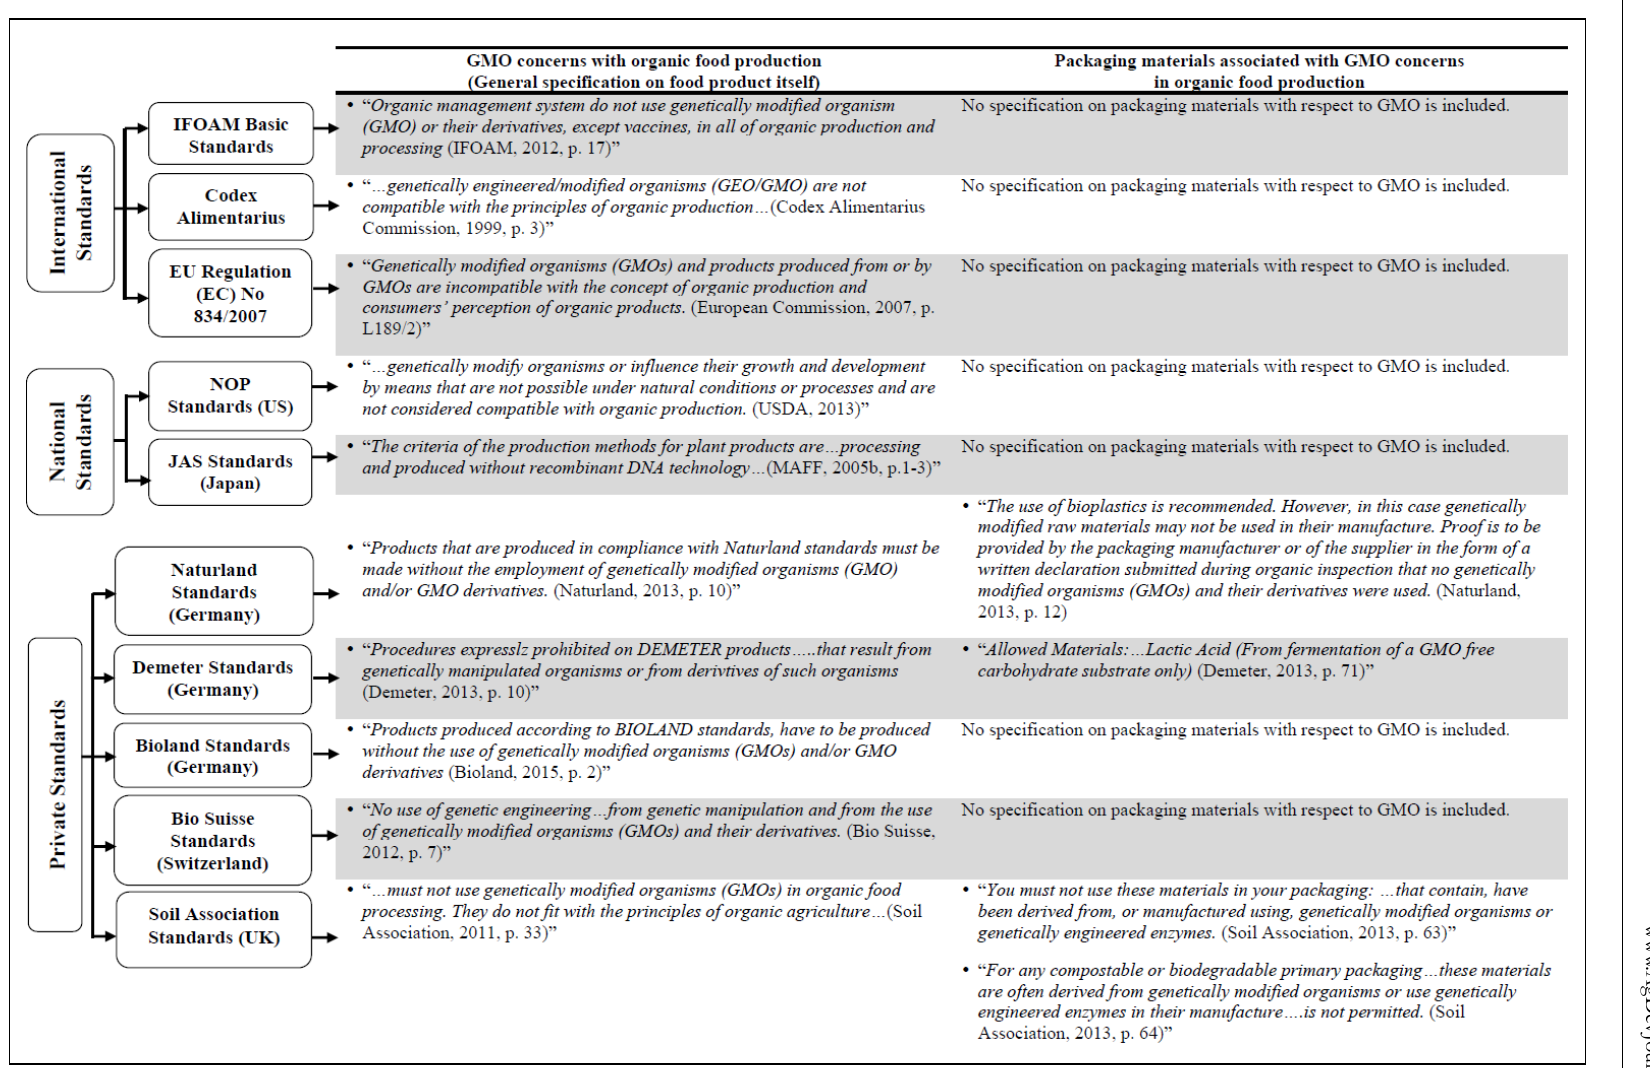
Figure 1. Comparison of Organic Production Regulations and Standards, with a Focus on GMO